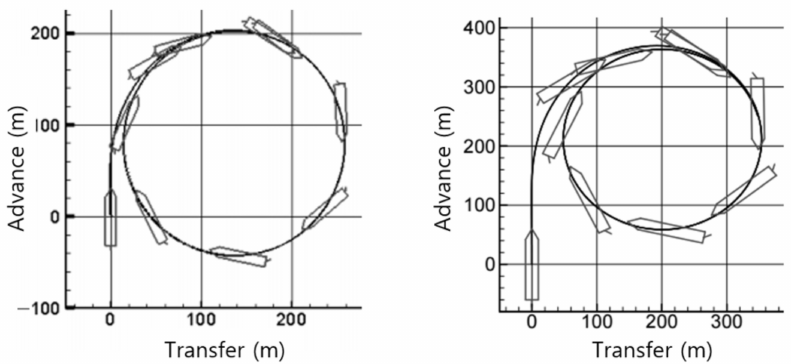
Figure 7. Turning circles of chemical tanker ( left ), training ship ( right